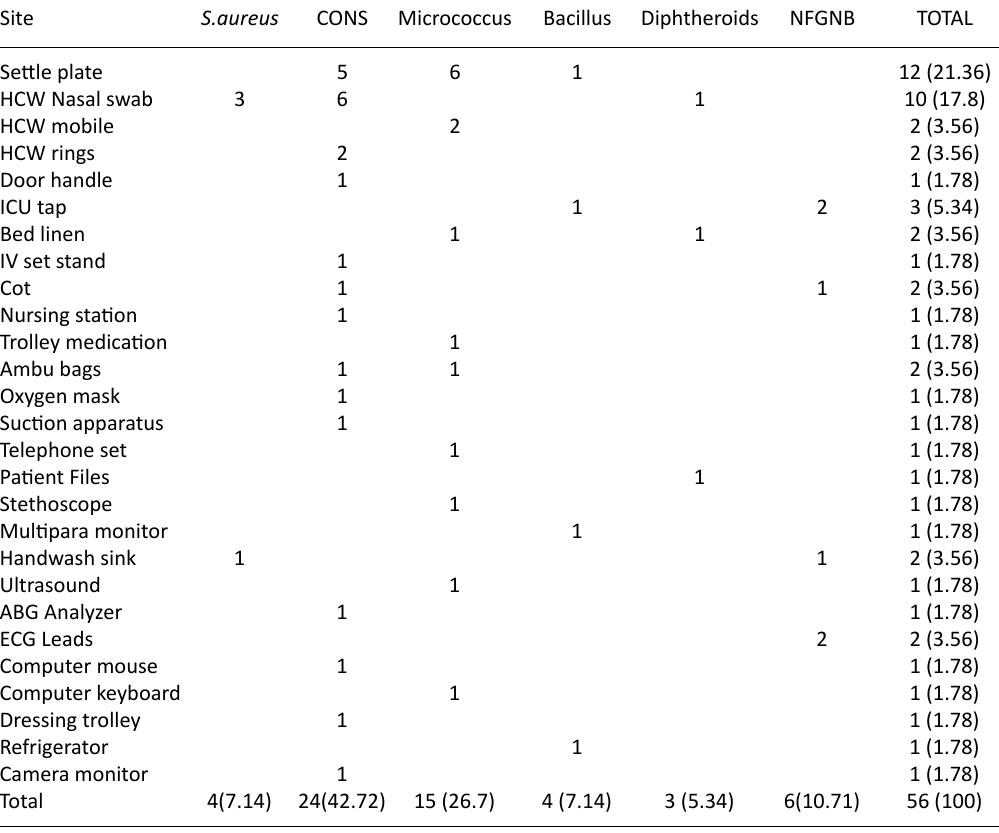
table 1. Distribution of bacteria on the various sites in ICU Site